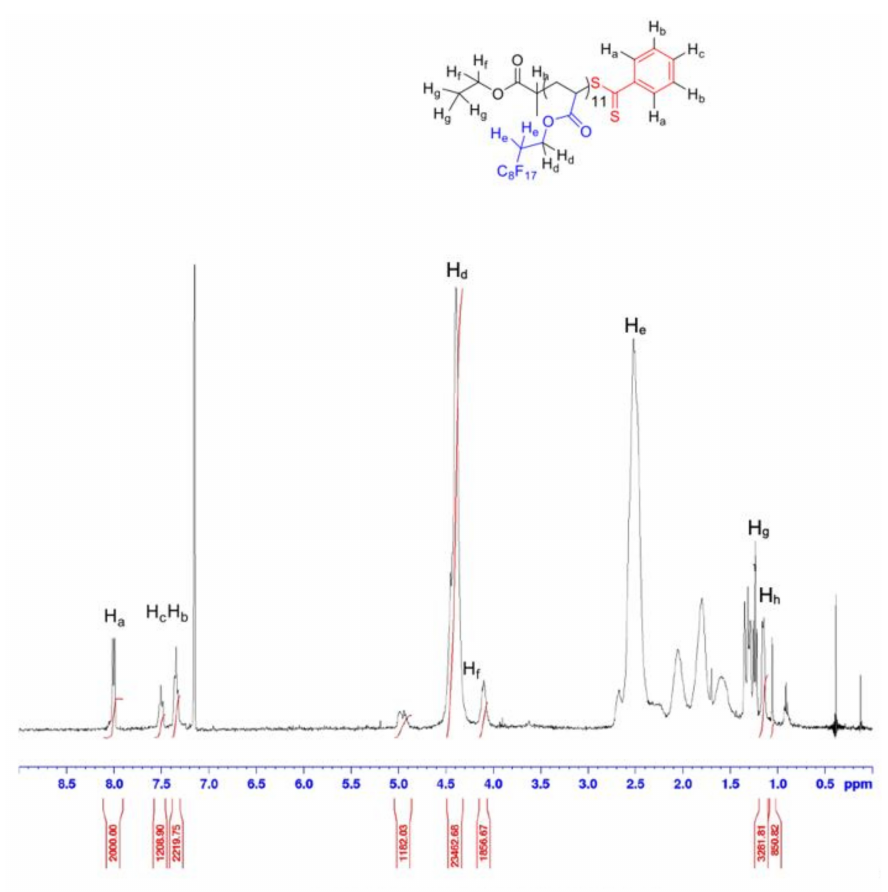
Figure 2. 1 H-NMR spectrum (400 MHz, CFC-113 + C 6 D 6 capillaries) of P(FDA) after